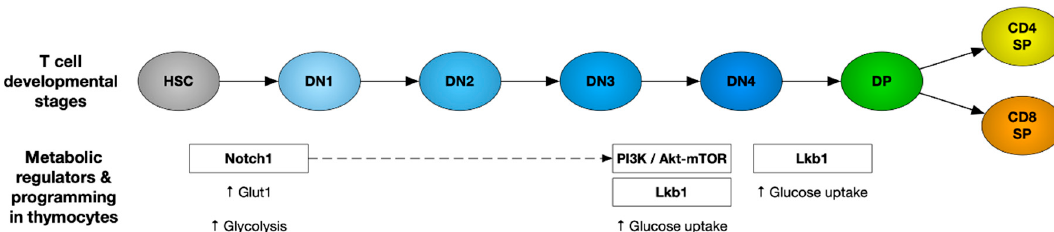
Figure 1. Metabolic regulators and pathways governing thymocyte development. Upregulation of glucose metabolism is the foremost requirement of developing thymocytes regulated by Notch, PI3K–AKT–mTOR and Lkb1 signaling pathways during different stages of T cell development as depicted here. HSC: hematopoietic stem cells, DN: CD4 − /CD8 − double-negative thymocytes, DP: CD4 + /CD8 + double-positive thymocytes, and SP: CD4 + CD8 − or CD8 + CD4 − single positive.